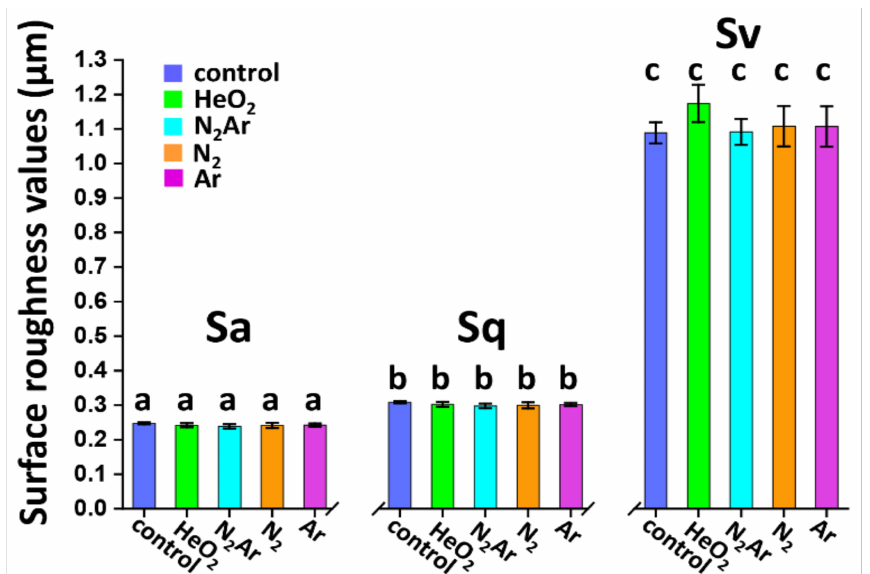
Figure 6. The surface texture parameters (Sa, Sq, and Sv) of each group. The identical letter shows no significant difference on Sa, Sq, and Sv values ( p >